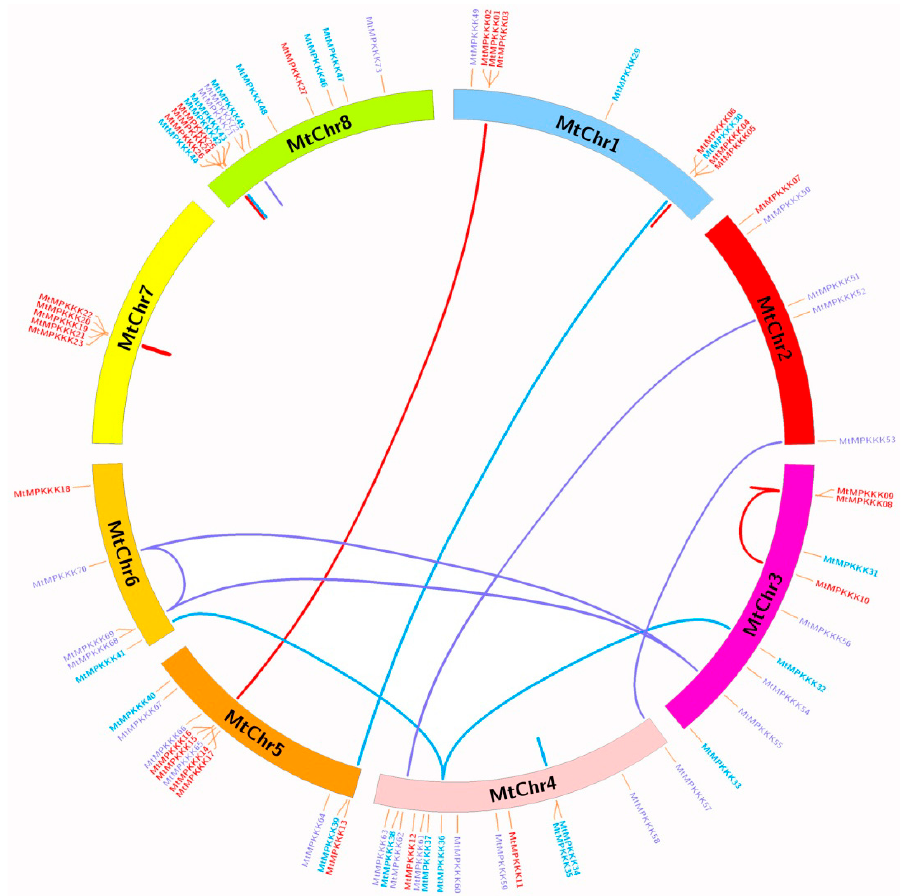
Figure 3. Chromosomal distribution and expansion analysis of MtMAPKKK genes in Medicago truncatula. Red lines show duplications between members of the MEKK subfamily, blue lines show duplications between members of the RAF subfamily, and purple lines show duplications between members of the ZIK subfamily.